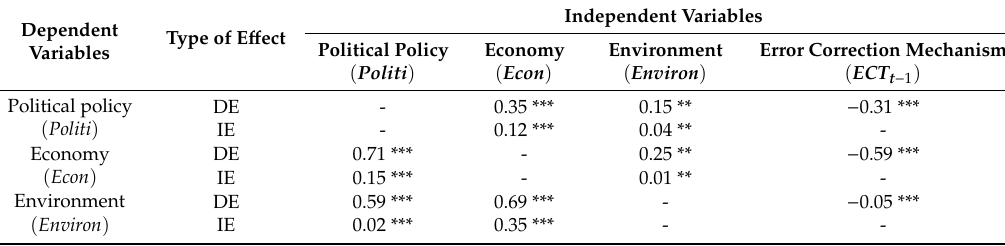
Table 3. Results of relationship size analysis of the Second Order